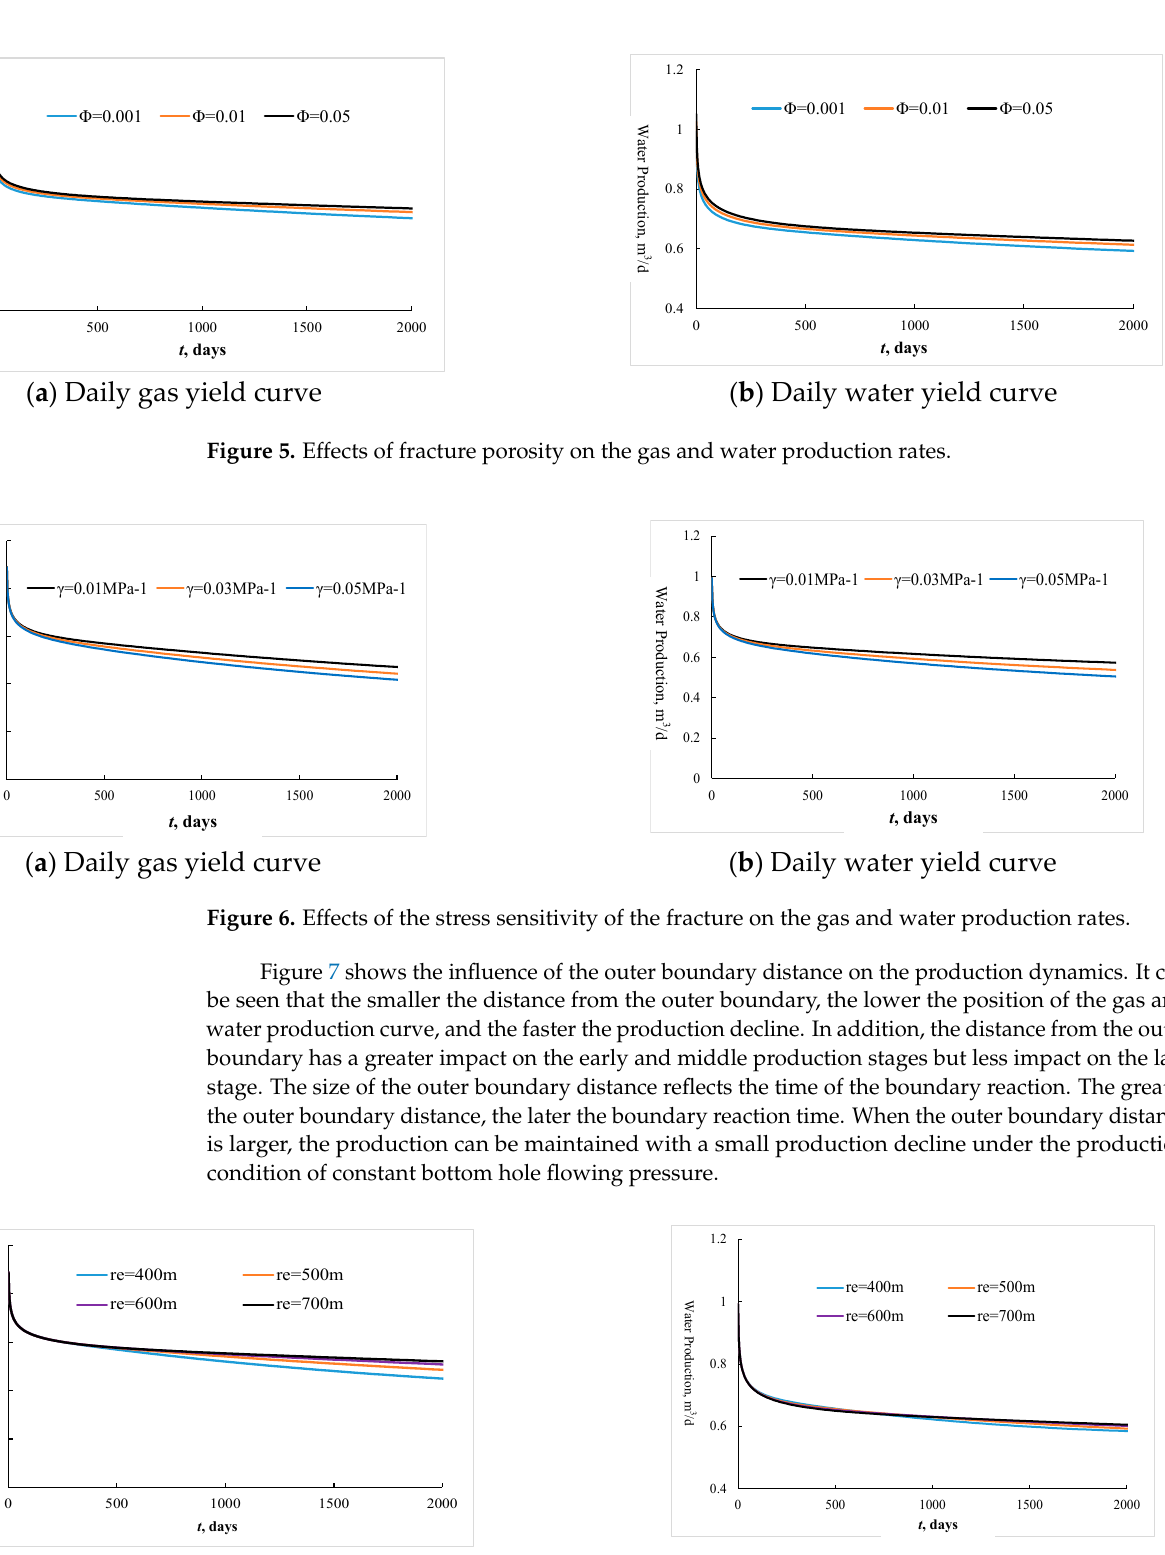
Figure 7. Effects of the radial distance of the external boundary on the gas and water production